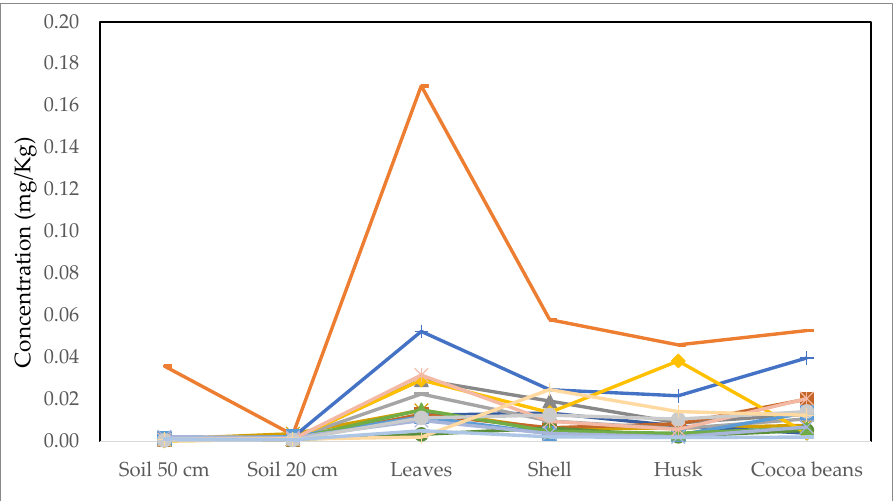
Figure 6. Cd content in soil and different parts of cocoa plant, the concentration is observed for 18 samples. The limit is 0.2 mg/Kg, and no sample exceeds this level.